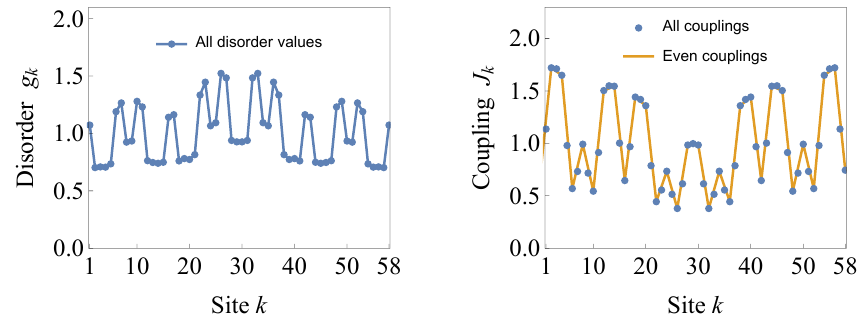
Figure 5 . Disorder values g k and coupling terms J k = 1 / ( g k g k +1 ) for the { 3 , 7 } MTN at the critical Ising point for N = 174 boundary sites, N/ 3 of which are shown here. The disorder values are extracted from the MTN boundary covariance matrix following (3.4). For the coupling terms, a linear interpolation is shown between the even terms J 2 i , showing that J 2 i +1 ≈ ( J 2 i + J 2 i +2 ) / 2